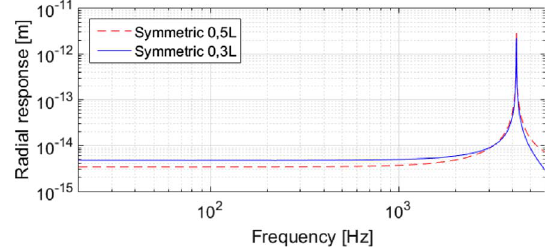
Figure 12. Radial response of a tube with symmetrical char- acteristics, excited by unitary internal pressure.